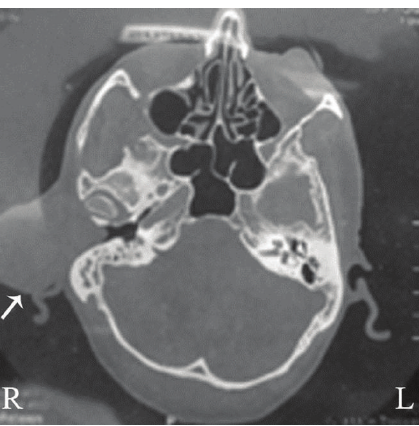
Figure 2: CT image shows the axial section of both temporal bones. The arrow indicates the tumor mass situated anterior to the right pinna involving outer part of the right external auditory canal.